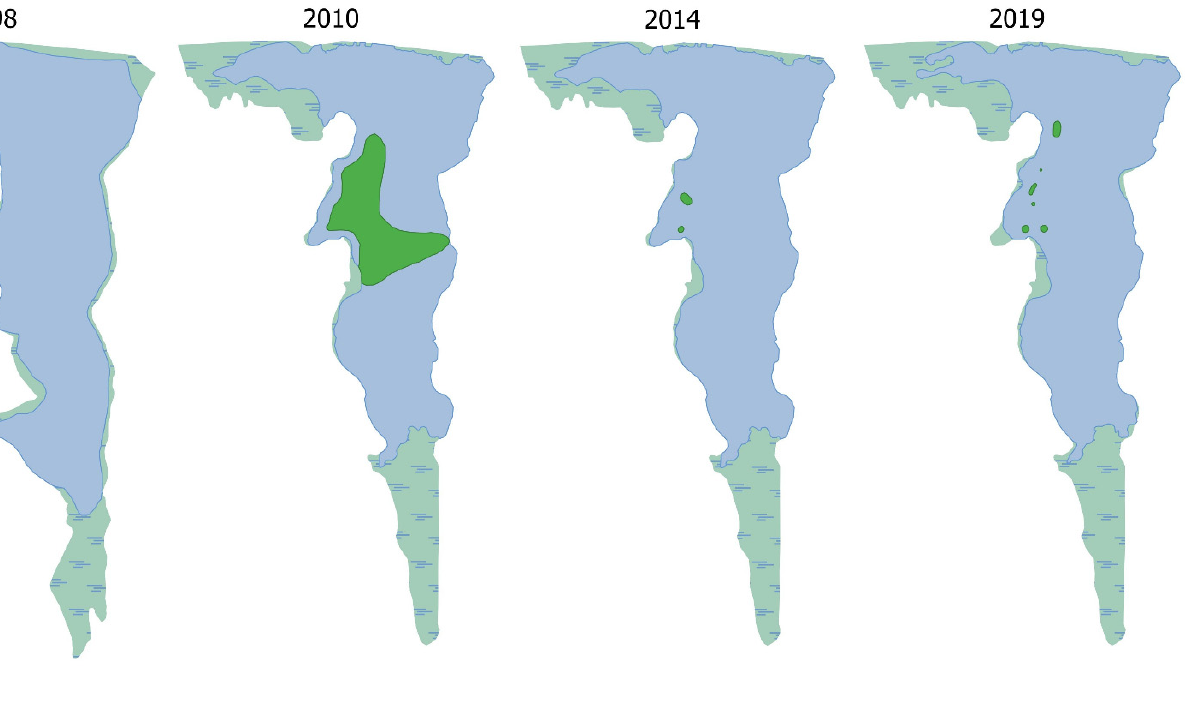
Figure 2. Changes in time of the T. natans distribution in the Szumirad reservoir.